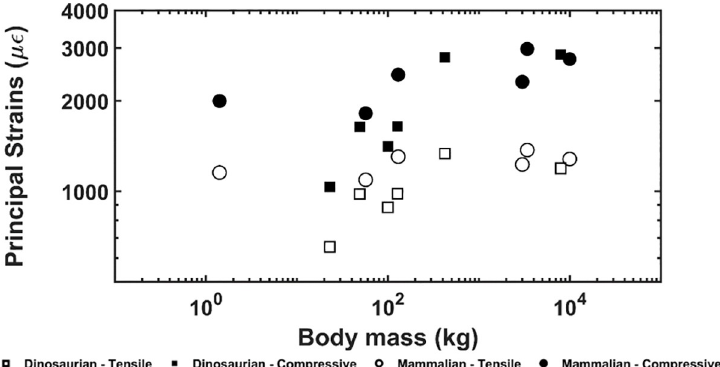
Fig 5. Average compressive and tensile principal strains versus body mass. Strains are shown in microstrain ( μ ε ). There is no correlation between body mass and the compressive/tensile principal strains in both mammalian and dinosaurian trabecular